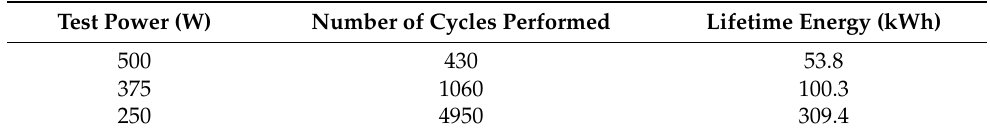
Table 3. Lifetime delivered energies.